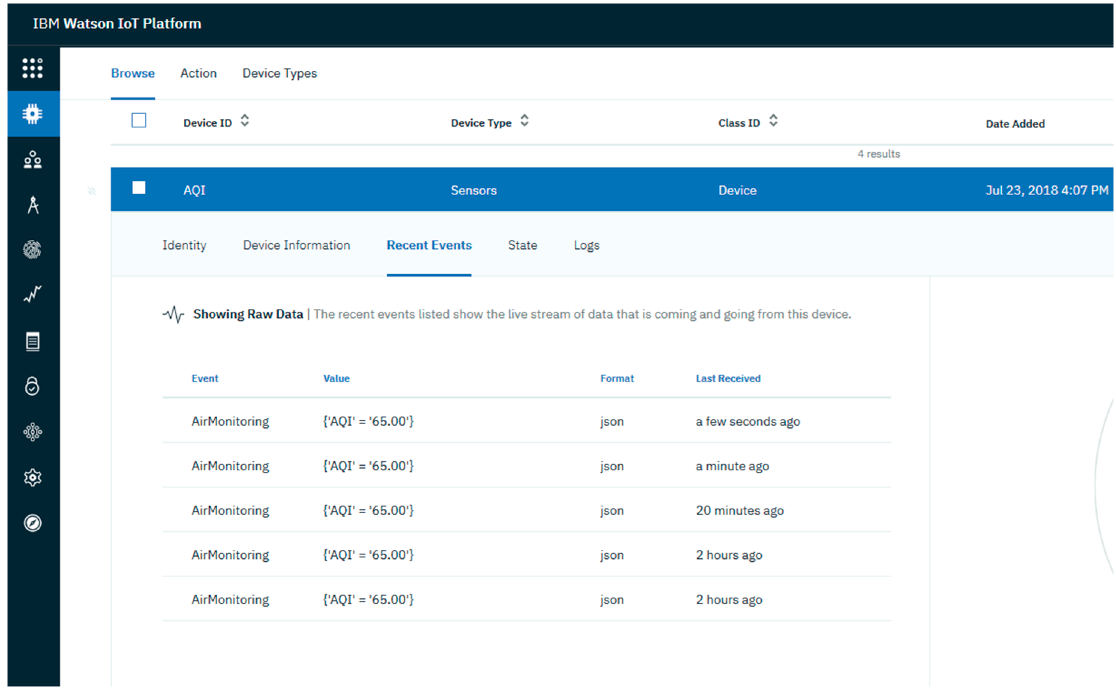
Figure 9. IBM Watson IoT platform for data visualization.